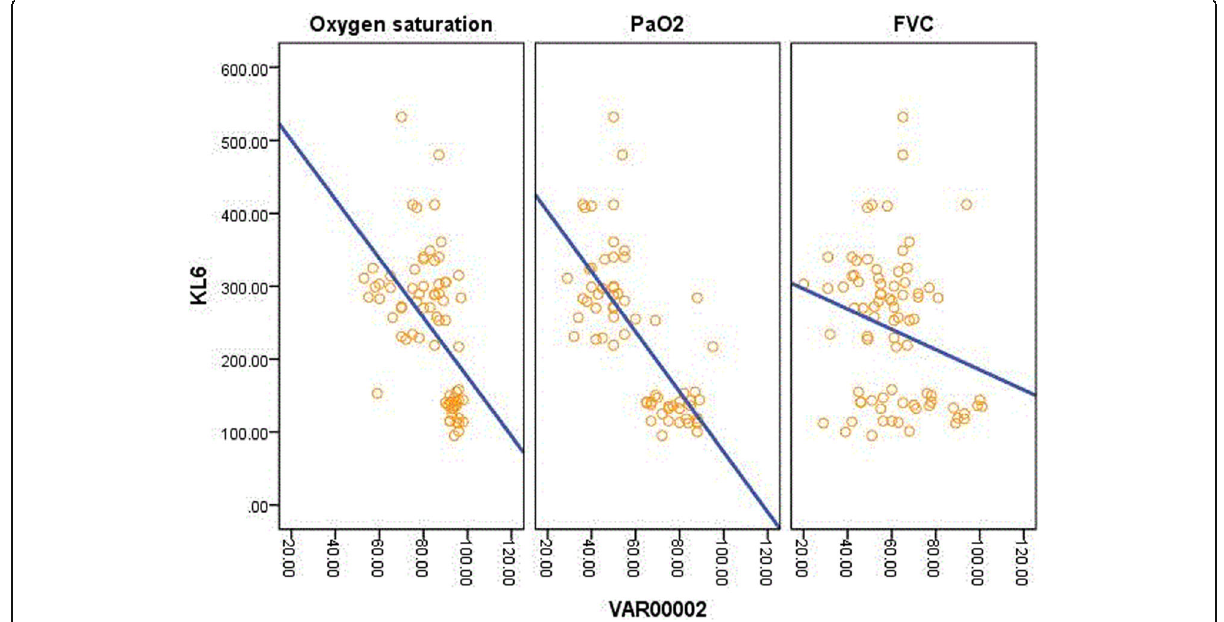
Fig. 5 Correlation between KL6 and O 2 saturation, PaO 2 , and FVC among all